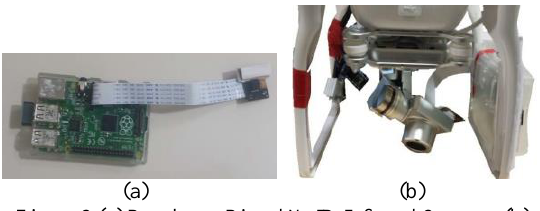
Figure 2 (a) Raspberry Pi and NoIR Infrared Camera.